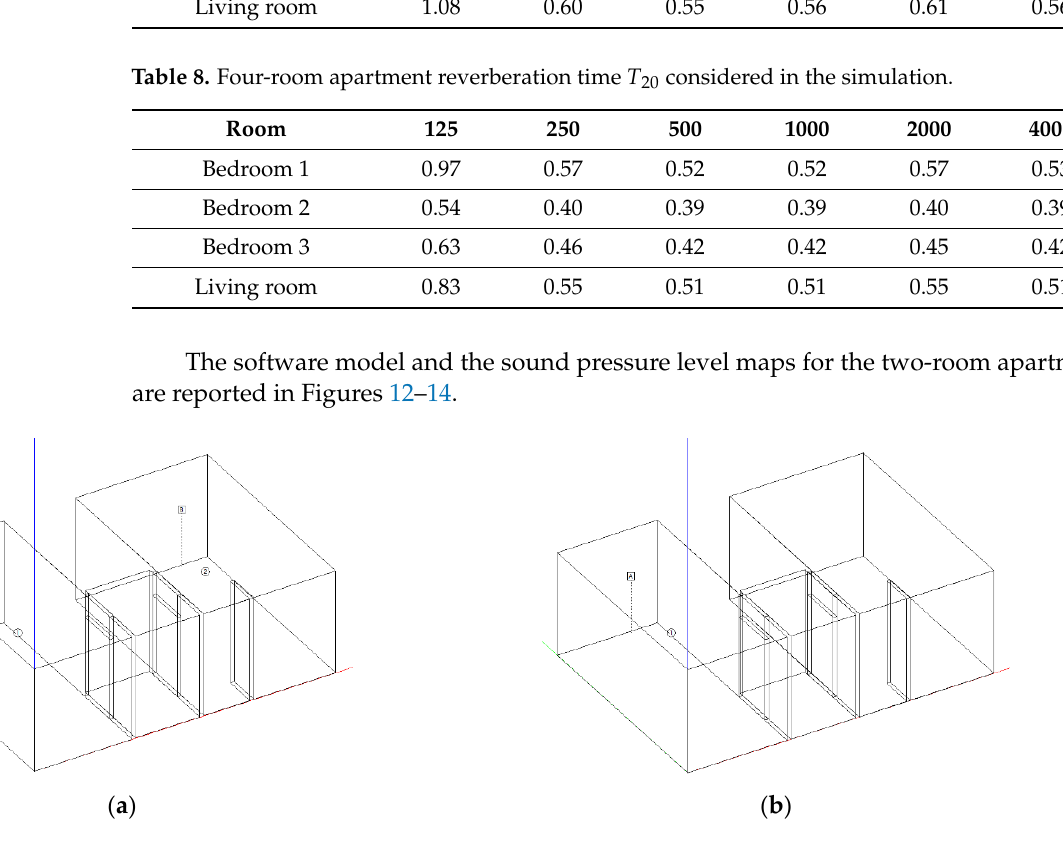
Figure 12. Two-room apartment. Night configuration: ( a ) all CVM on, ( b ) only bedroom CVM on.